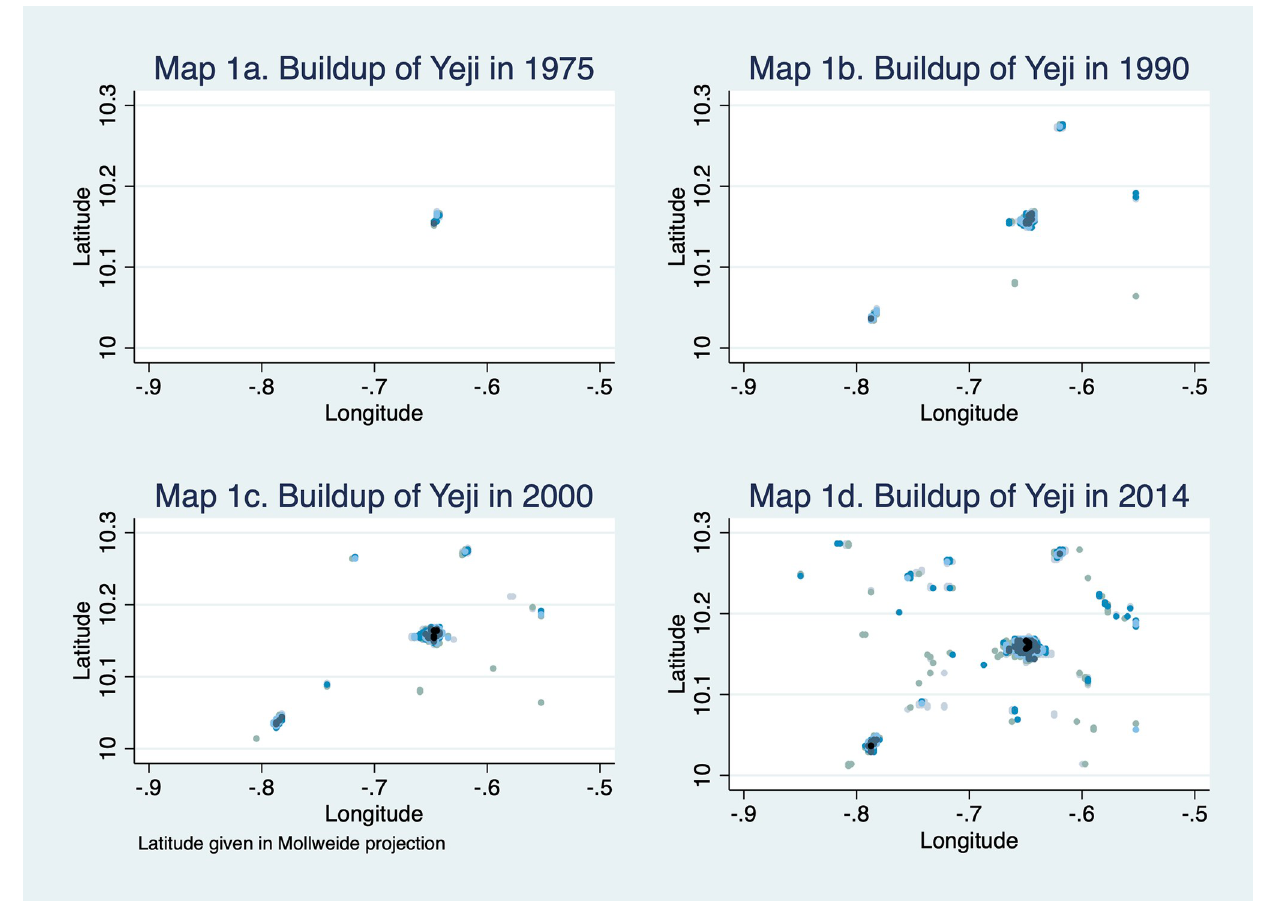
Fig 1. Map 1. Buildup of Yeji over